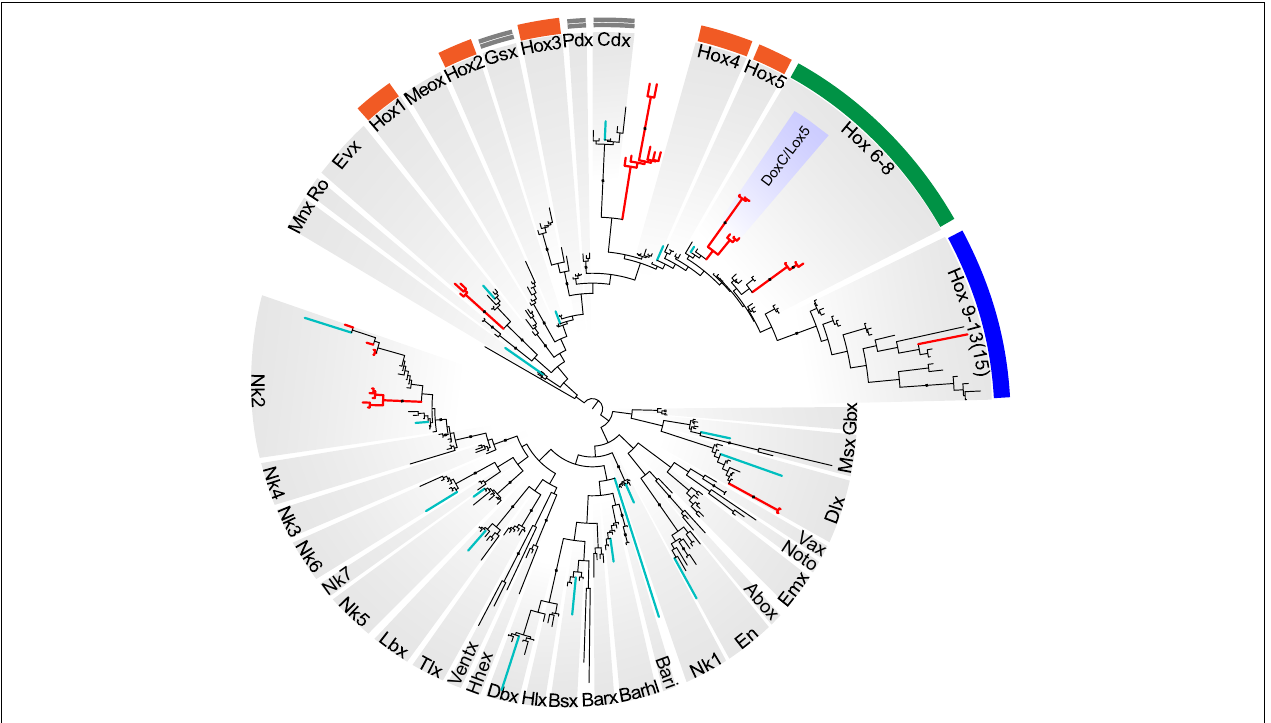
FIGURE 8 | Bayesian tree of the ANTP class homeodomain sequences from Homo sapiens , Drosophila melanogaster , Capitella teleta , Octopus bimaculoides , Intoshia linei , and three dicyemids: Dicyema sp. 1, Dicyema sp. 2, and Dicyema japonicum . The dicyemid sequences are given in red, and the orthonectid homeoboxes are labeled with teal color. The groups of anterior Hox genes (Hox1-5) are outlined in orange, the central Hox genes (Hox6-8) – in green, and the posterior Hox genes (Hox9-13) – in blue; ParaHox orthologs (Gsx, Pdx, and Cdx) are marked with a double line. The dicyemid DoxC/Lox5 genes are labeled inside the group of central Hox genes. Nodes with ≥ 0.95 posterior probability are marked with black